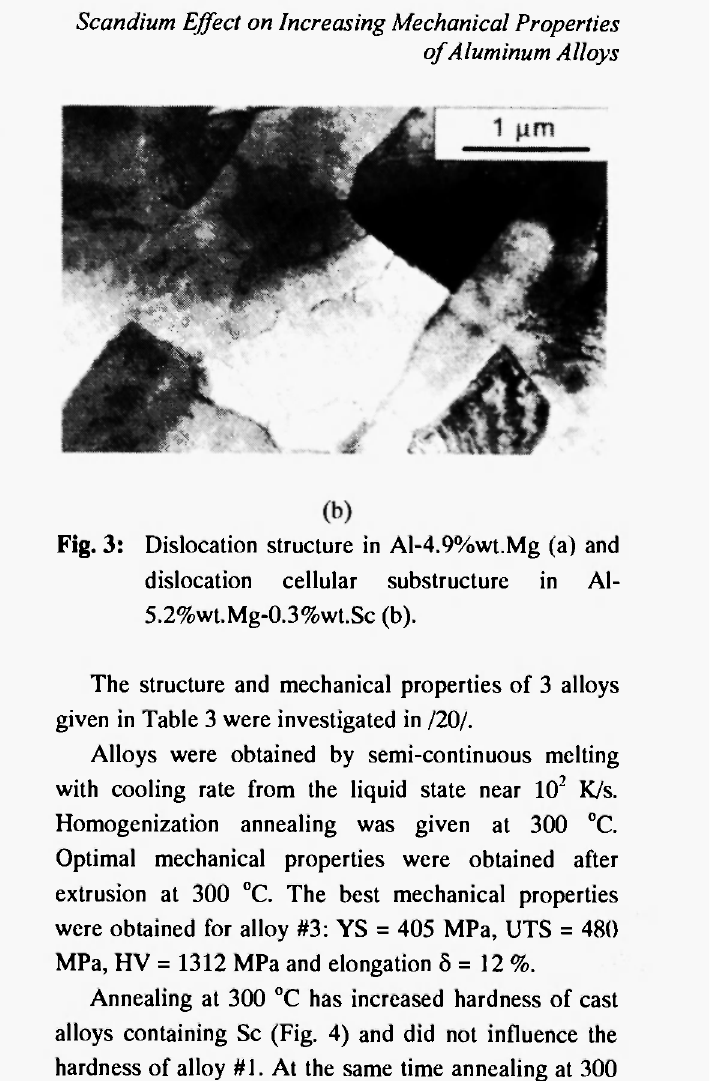
Chemical compositions of Al-Mg-Mn-Sc alloys. Alloy # Chemical composition, %wt.